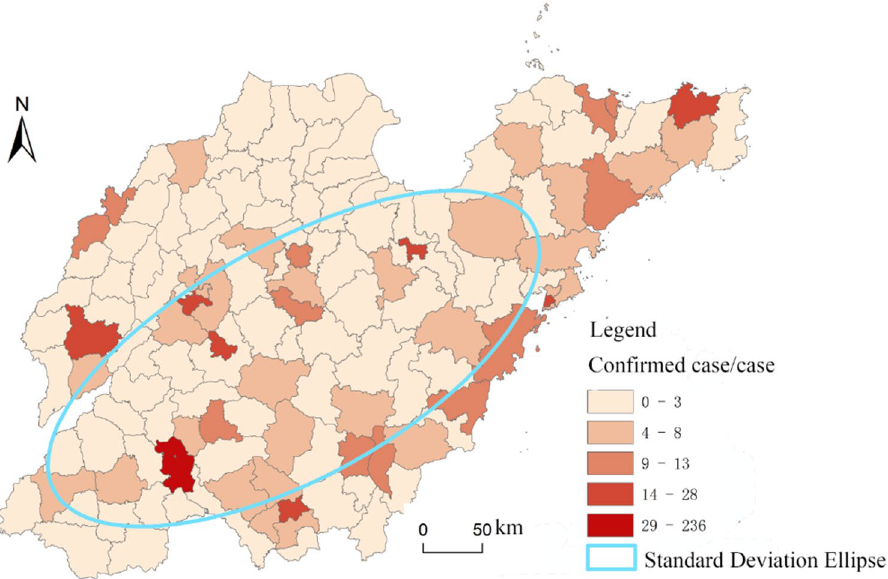
Figure 9. Spatial distribution of confirmed COVID-19 cases in Shandong province (this graph is produced by using ArcGIS10.3. http:// www. esri. com; The base map is from China Standard Map Service. http:// bzdt. ch. mnr. gov. cn/).